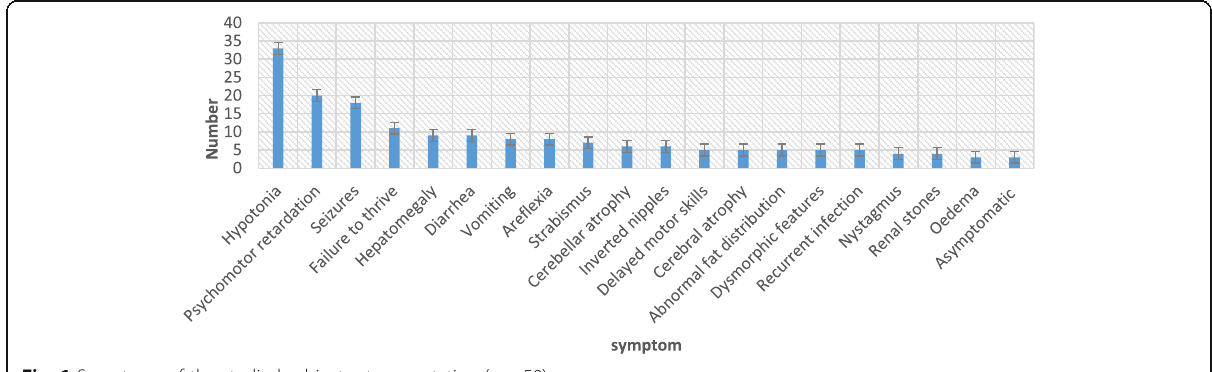
Fig. 1 Symptoms of the studied subjects at presentation ( n =